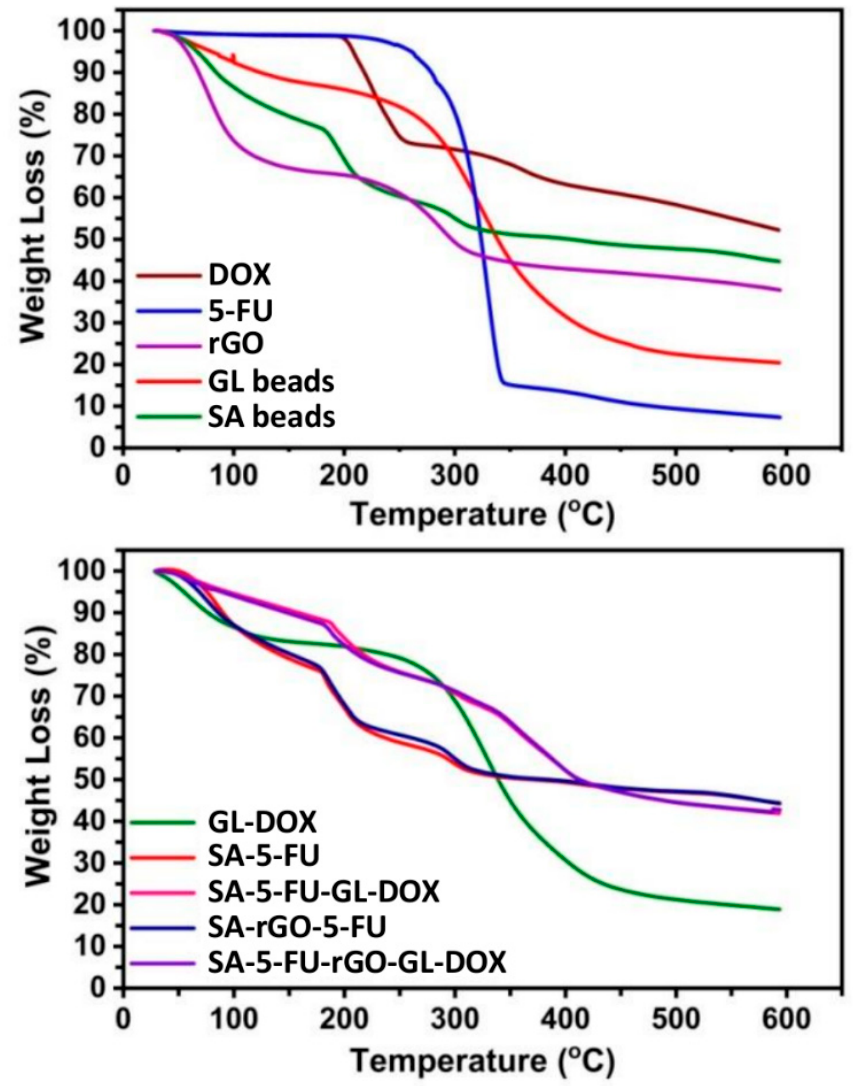
Figure 4. TGA curves of different beads (GL beads, SA beads, GL-DOX, SA-5-FU, SA-5-FU-GL-DOX, SA-rGO-5-FU and SA-5-FU-rGO-GL-DOX) and their constituents (rGO, DOX and 5-FU).